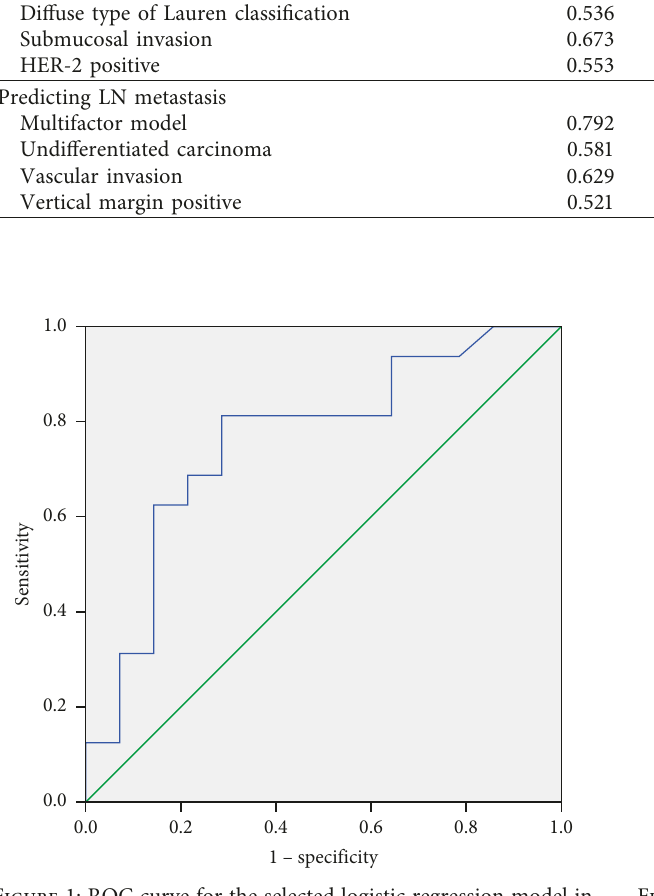
Figure 2: ROC curve for the selected logistic regression model in the diagnosis of LN metastasis. Area under the curve � 0.792; sensitivity � 80.0%; specificity �